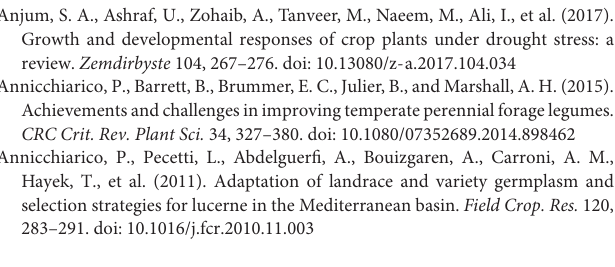
Supplementary Figure 5 | (A) Phylogenetic analysis of the sucrose synthase (SUS) family in Medicago truncatula ( Mt ), Oryza sativa , Glycine max , and Arabidopsis thaliana . A maximum likelihood tree was constructed with MEGA 10.1 (https://www.megasoftware.net/) using the predicted amino acid sequences based on the Whelan And Goldman (WAG) model (Whelan and Goldman, 2001). Values on the branches represented bootstrap values (1,000 repetitions). SUS gene names for Mt and A. thaliana were specified in brackets. (B) Expression levels of the SUS family in Mt based on the RNA-sequencing data extracted from the MtSSPdb database (https://mtsspdb.noble.org/database/). RPM, reads per million. Supplementary Table 1 | Metabolomic analysis methods and matrices. Complete list of identified metabolites, parameters for the separation and mass spectrometric identification of compounds, and raw and normalized matrices of quantified metabolites. Supplementary Table 2 | Relative quantification and fold change ratios of metabolites detected in Medicago sativa and M. truncatula leaf, taproot and fibrous root tissues under control (C), moderate deficit (MD), and severe deficit (SD) conditions. Values represent means ± SEs ( n = 5 biological replicates), Ac, acid. Supplementary Table 3 | Primer sequences used for qRT-PCR analysis. Ms , Medicago sativa ; Mt , M. truncatula ; SUS1 , sucrose synthase 1. Supplementary Table 4 | Interactions between plant species/organ and treatments using two-way ANOVA statistical analysis. ∗∗∗ , ∗∗ , and ∗ asterisks indicate statistical significance at the 0.001, 0.01, and 0.05 level, respectively; ns, not significant at the 0.05 level. C, carbon; DW, dry weight; G6PDH, glucose-6-phosphate dehydrogenase; INV, alkaline invertase; N, nitrogen; SUS, sucrose synthase; WD, water deficit. Supplementary Table 5 | List of metabolites with contents significantly altered by severe water deficit (Student’s t -test; P ≤ 0.05) in leaves, taproots (tapRs), and fibrous roots (fibRs) of Medicago sativa (Ms) and M. truncatula ( Mt ). Metabolites identified in Figures 3 and 4 with a discriminant loading value higher than 0.2 were marked with gray background and represented in the heatmap ( Figure 5 ) with bold letters. ID represent each metabolite identifier in the analysis extracted from Supplementary Table 1 . Supplementary Table 6 | List of metabolites showing an organ or species interaction based on ANOVA, as represented in Figure 5 . Values represent means ± SEs ( n = 5 biological replicates) of normalized intensity values. Metabolites showing organ effects in Medicago sativa, M. truncatula , and both species were represented in green, orange, and brown, respectively. Metabolites showing species-related effects in taproots, fibrous roots and both root systems were represented in yellow, blue, and gray, respectively. Metabolites sharing organ effects to both species and species effects in both organs were represented in bold. C, control; MD, moderate water deficit; SD, severe water deficit; fibRs, fibrous roots; tapRs, taproots; Ms, Medicago sativa; Mt, M. truncatula . Supplementary Table 7 | Normalized values of metabolites related to carbon metabolism detected in taproots (tapRs) and fibrous roots (fibRs) of Medicago sativa ( Ms ) and M truncatula ( Mt ) plants under control (C) and severe deficit (SD) conditions. Values highlighted in orange indicate a significant increase in SD plants relative to well-irrigated plants (C). Values highlighted in blue indicate a significant decrease in tissues subjected to water deficit relative to C plants. Data were presented as means ± SEs ( n = 5 biological replicates). Different letters indicate significant differences as determined by a Duncan test ( P ≤ 0.05). Ac, acid; GABA, γ -aminobutyric